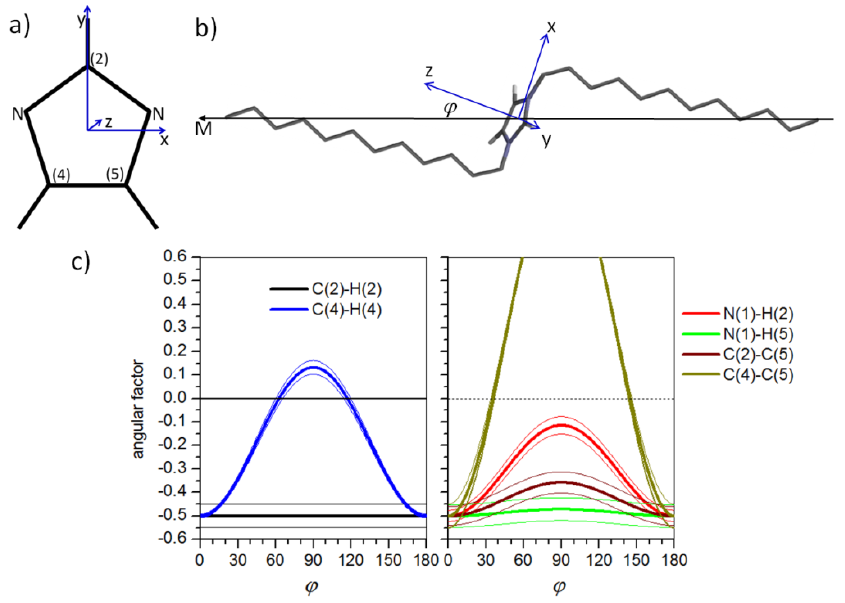
Figure 6. ( a ) Coordinate axis frame for the imidazolium ring. ( b ) Schematic illustration of the imidazolium core alignment to the cation long axis. ( c ) Dependence of the angular parameters of internuclear vectors P = ( 3cos 2 θ Z − 1 ) /2 + η S ( cos 2 θ X − cos 2 θ Y ) /2 on the tilt angle φ . Three sequential lines for each vector correspond to the biaxiality parameter values η S = ( S xx − S yy ) / S zz = − 0.1, 0, and +0.1.